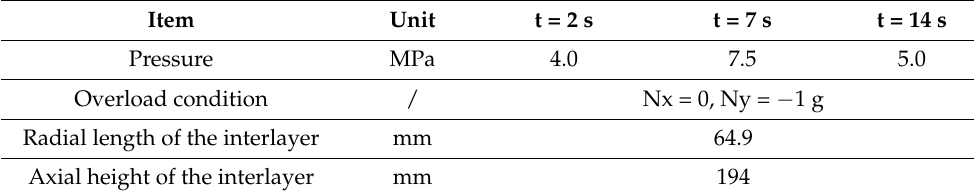
Table 2. The working condition parameters for the calculation.